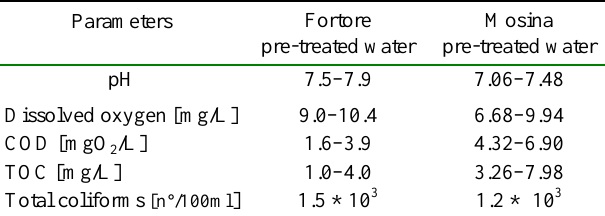
Table 1. Fortore and Mosina water characteristics.